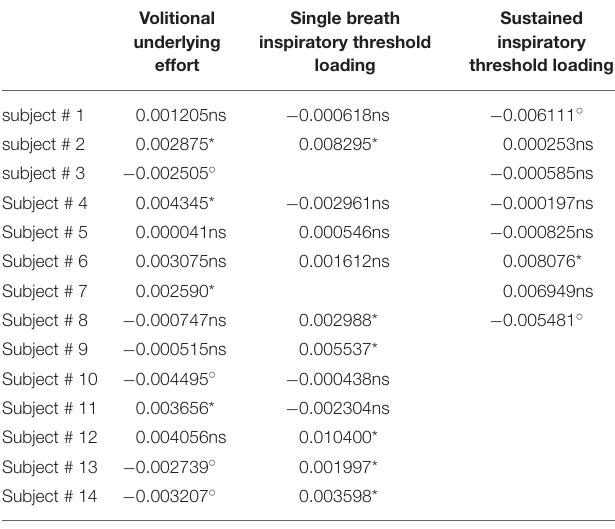
TABLE 2 | Slope of the gastric to transdiaphragmatic pressure ratio (Pga/Pdi) over the range of underlying Pdi studied during the three experimental